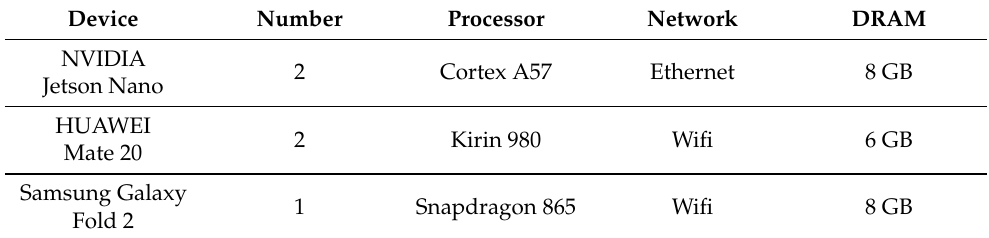
Table 4. Summary of heterogeneous devices.